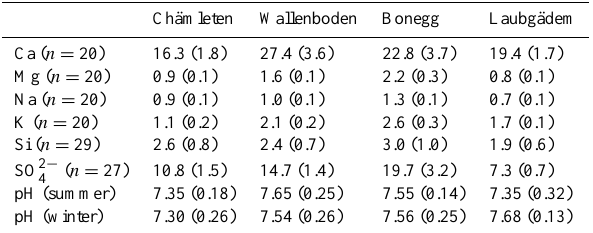
Table 4. Means and standard deviations of geochemical parameters of stream base flow samples in mgL − 1